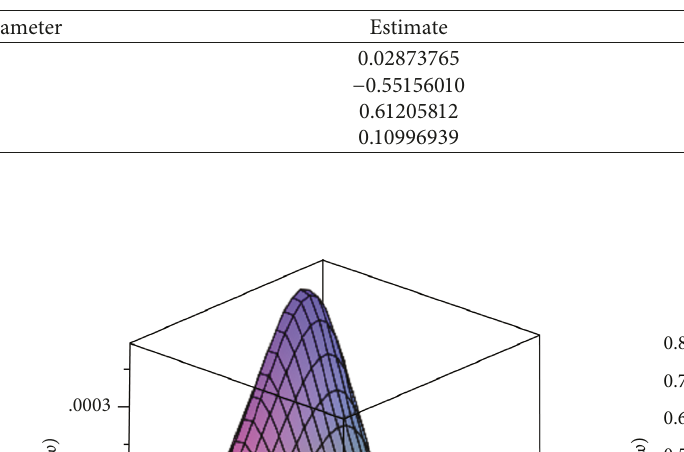
Figure 4: Statistical functions fitted for the dataset: (a) joint density function, (b) cumulative function, (c) hazard function, (d) copula function, (e) contour plot of copula function, and (f)–(i) marginals. Table 3: Estimated parameters for the UEFA Champion’s League data with AIC and